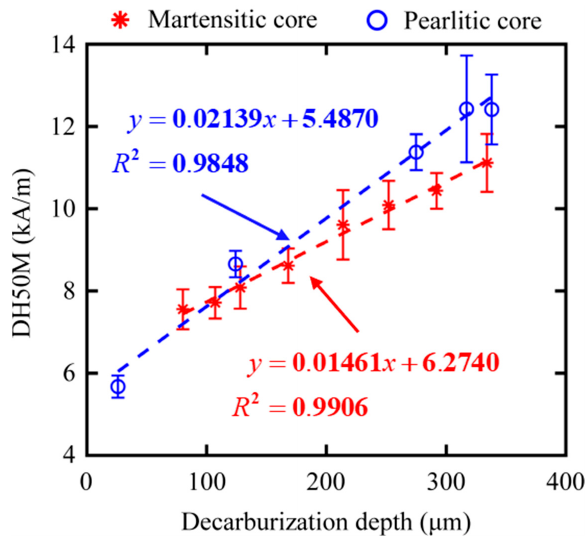
Figure 10. Dependencies of feature DH50M on the surface decarburization depths for all samples with martensitic and pearlitic cores.